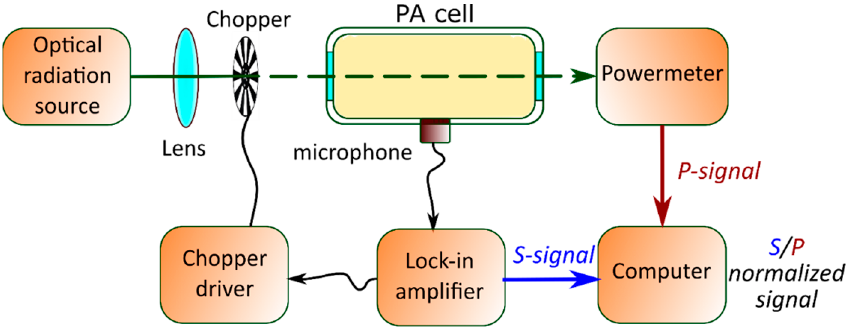
Figure 11. Typical setup for PAS measurements with resonance PA cells.